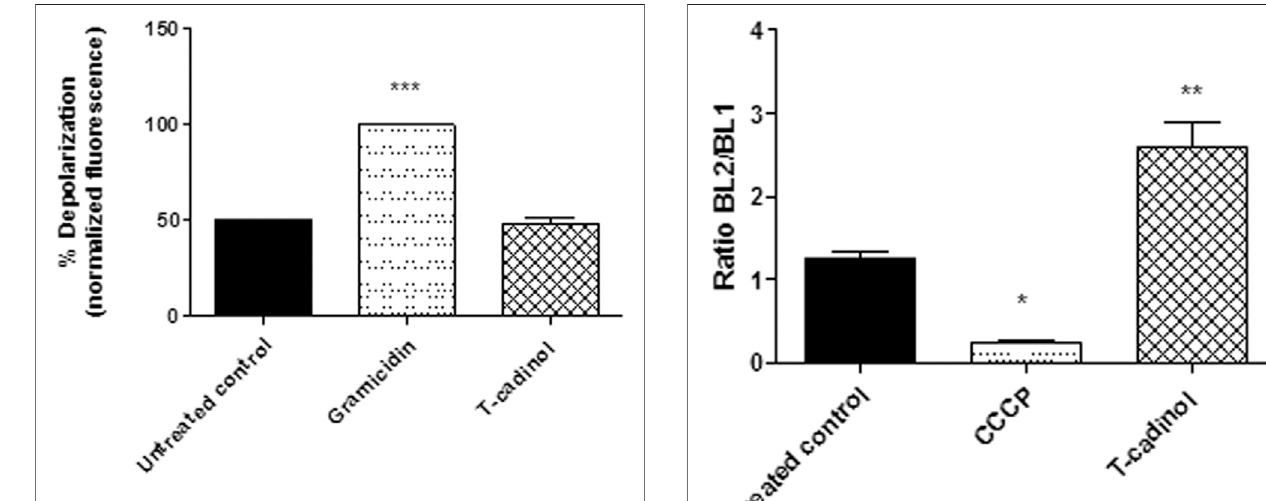
FIGURE 4 | – Evaluation of plasma membrane electric potential ( ΔΨ p) in T. cruzi trypomastigotes treated with compound 1 (T-cadinol − 18.2 μ M) for 4 h. DISBAC2(3) dye fl uorescence was measured by fl ow cytometry (excitation 488 nm and emission 574 nm). Untreated trypomastigotes were used to achieve minimal depolarization and treated with gramicidin D (0.5 µg/ml) to achieve the maximum. Fluorescence was normalized with respect to gramicidin D (100%). *** p < 0.0001.